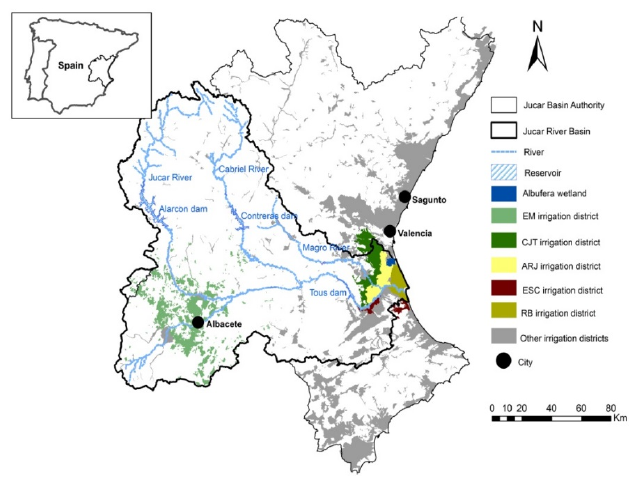
Figure 1. Map of the Jucar River Basin.